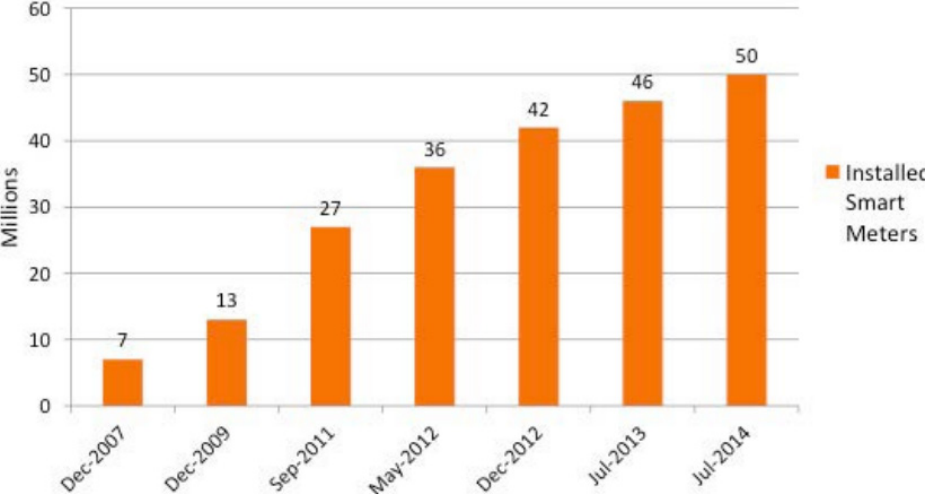
Figure 7. Evolution of SM s installed in recent years in the U.S. [62]. Reproduced with the permission of A. Cooper, “Utility-Scale Smart Meter Deployments: Building Block of the Evolving Power Grid”; published by Edison Foundation, 2014.